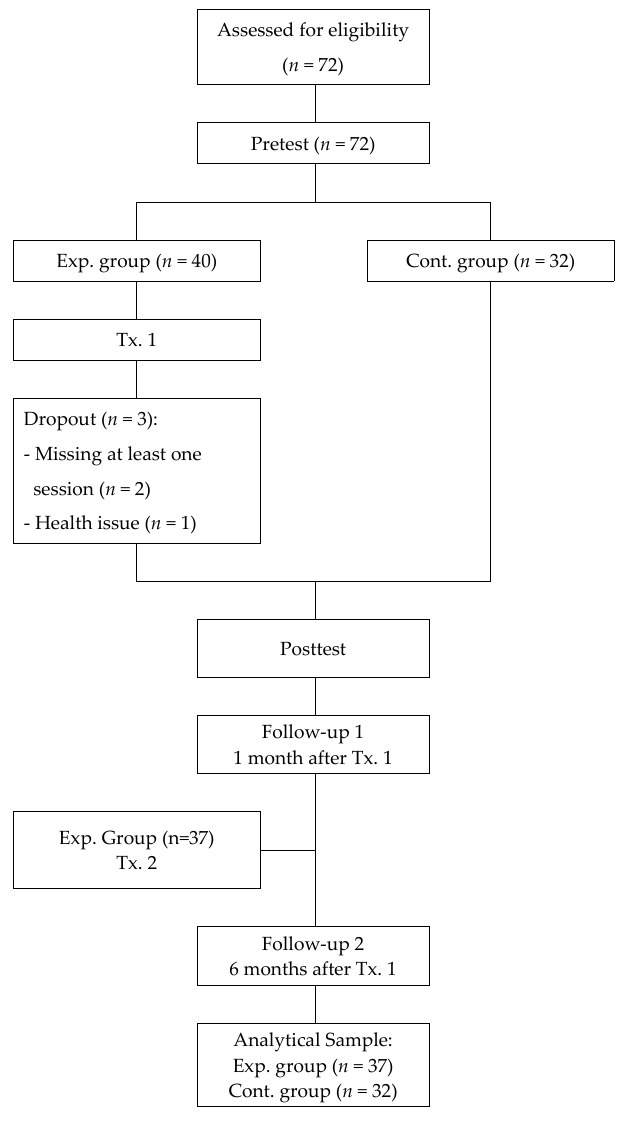
Figure 1. Flow chart of the study.